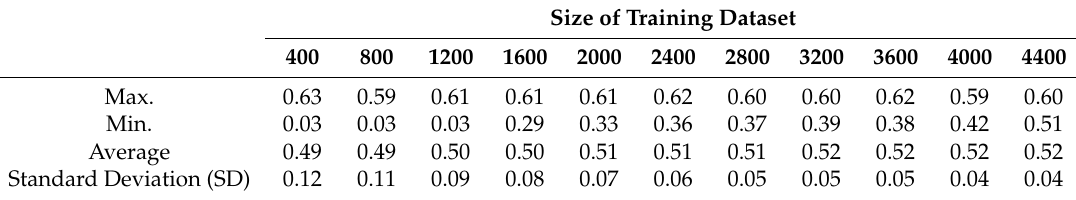
Table 6. Model accuracy with testing 11 building characteristics for spectral-yield acceleration S ay .